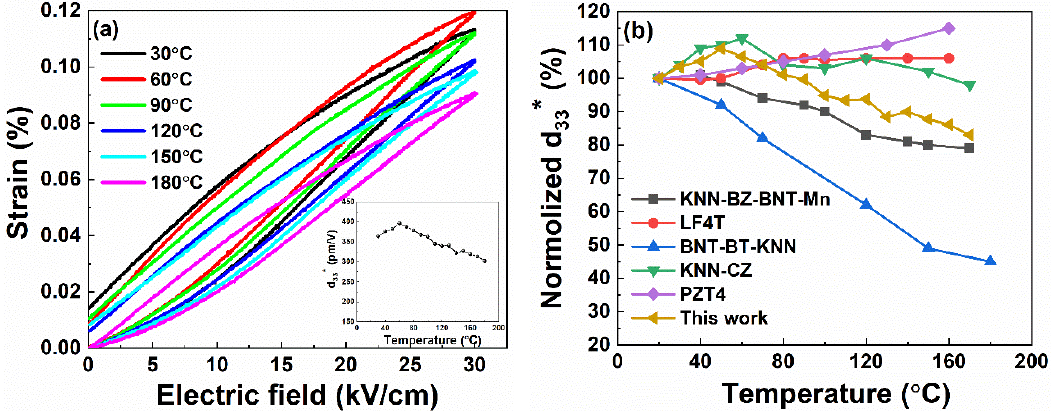
Figure 6. ( a ) Unipolar strain – electric field ( S – E ) curves at different temperatures for the 0.92KNLN- 0.08BZ ceramic sintered using the 3-step/20 h method (inset shows variation in d 33 * with temperature); and ( b ) comparison of temperature dependence of the piezoelectric strain d 33 * value of different piezoelectric ceramics, as normalized to the room temperature d 33 * RT value.